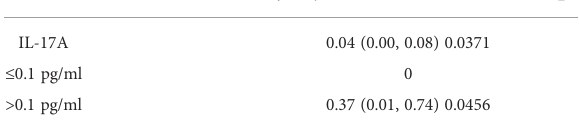
TABLE 4A Multiple regressions analyses between serum IL-17A and best overall effect (BOE) in different models. Variable